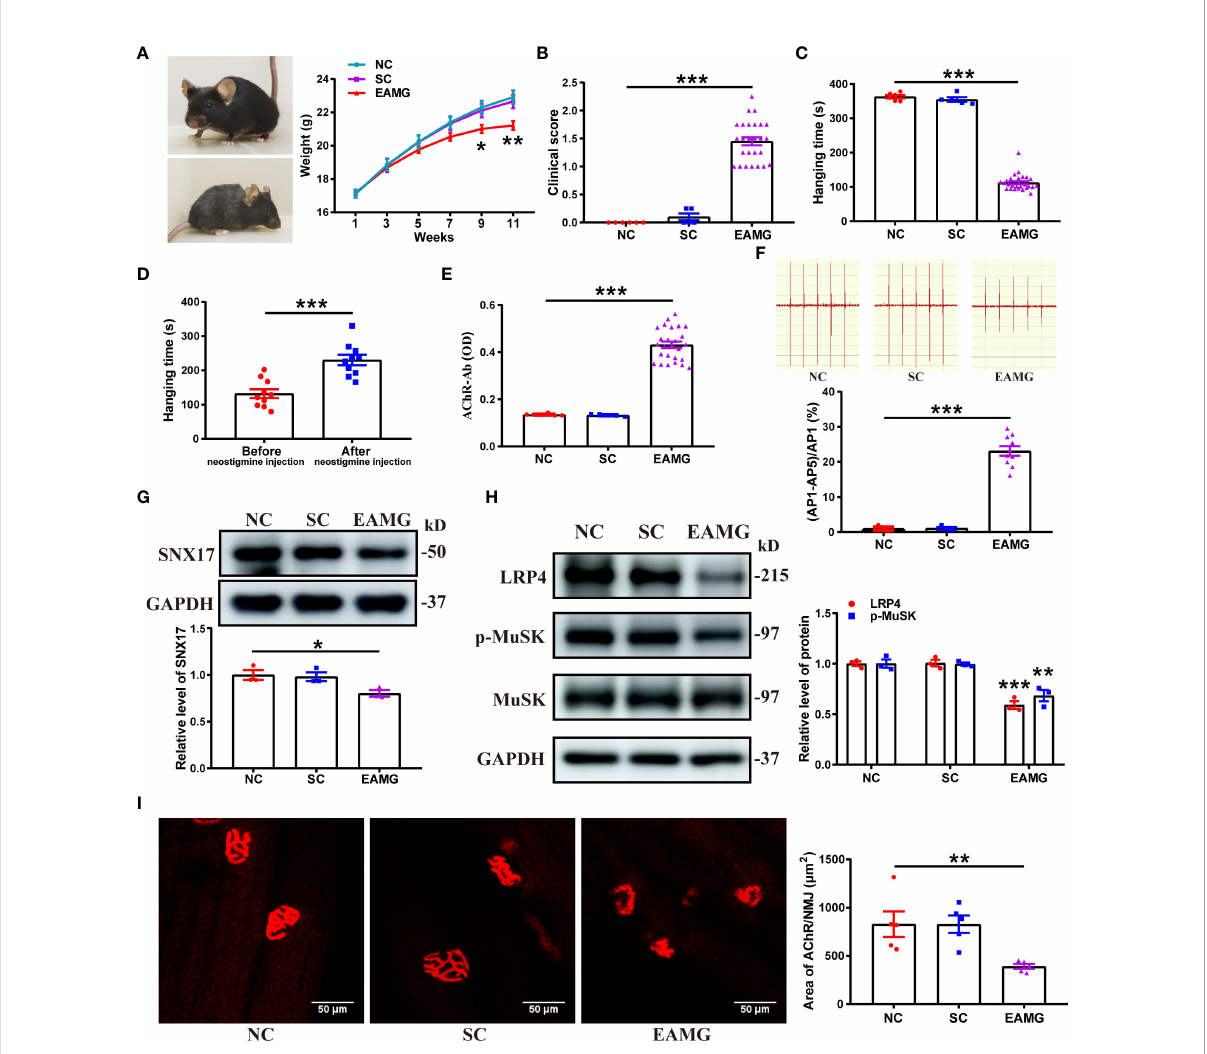
FIGURE 4 SNX17 expression was decreased in the gastrocnemius muscle of EAMG mice, and AChR was fragmented at the NMJ. (A) Representative mice in the normal group (upper left) and the EAMG group (lower left); weight gain in mice in each group between 1 and 11 weeks (right panel). NC: n = 6; SC: n = 5; EAMG: n = 26. (B) Lennon grading method to clinical score myasthenic symptoms in mice in each group. NC: n = 6; SC: n = 5; EAMG: n = 26. (C) Hanging time of mice in each group was measured by the fl ip suspension test. NC: n = 6; SC: n = 5; EAMG: n = 26. (D) Hanging time of 10 randomly selected EAMG mice before and 20 min after injecting neostigmine, measured by the fl ip suspension test. n = 10/ group. (E) Concentration of AChR-Ab in serum was detected using ELISA. NC: n = 6; SC: n = 5; EAMG: n = 26. (F) EMG of the gastrocnemius muscle was determined using low-frequency RNS. The attenuation rate of the fi fth amplitude of EMG compared with the fi rst amplitude was calculated. NC and SC: n = 3/group; EAMG: n = 10. Western blotting analyses of the expression levels of (G) SNX17, and (H) LRP4, MuSK, and p- MuSK in the mouse gastrocnemius muscle tissue. n = 3/group. (I) AChR (red) at the NMJ of the gastrocnemius fi laments was labeled with R-BTX and the area of AChRs was quanti fi ed with ImageJ. n = 5/group; Scale bar = 50 m m. All data are presented as mean ± SEM. * P <0.05, ** P <0.01, *** P <0.001. AChR, acetylcholine receptor; EAMG, experimental autoimmune myasthenia gravis; LRP4, low-density lipoprotein receptor-related protein 4; MuSK, muscle-speci fi c receptor tyrosine kinase; NC, normal control; NMJ, neuromuscular junction; R-BTX, rhodamine-labeled bungarotoxin; RNS, repetitive nerve stimulation; SC, solvent control; SEM, Standard Error of Mean; SNX17, sorting nexin